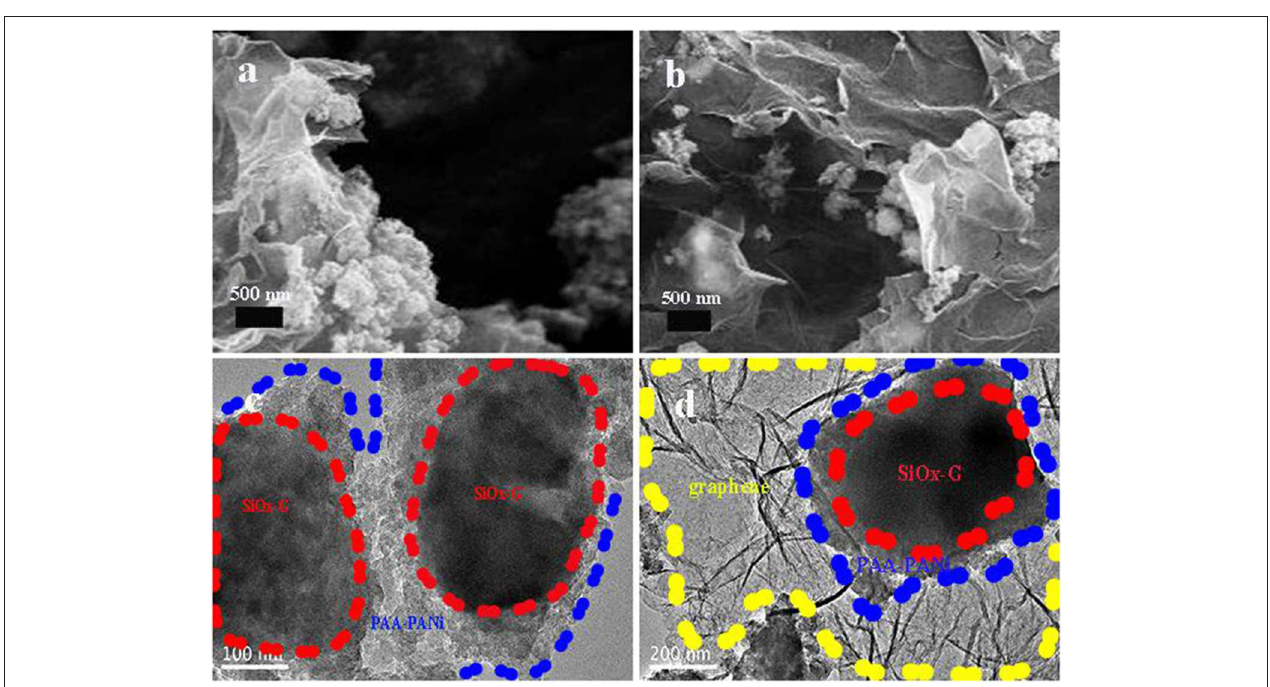
FIGURE 4 | (a,b) SEM images of SiO x -G/PAA-PANi/graphene; (c) TEM image of SiO x -G/PAA-PANi; (d) TEM image of SiO x -G/PAA-PANi/graphene.